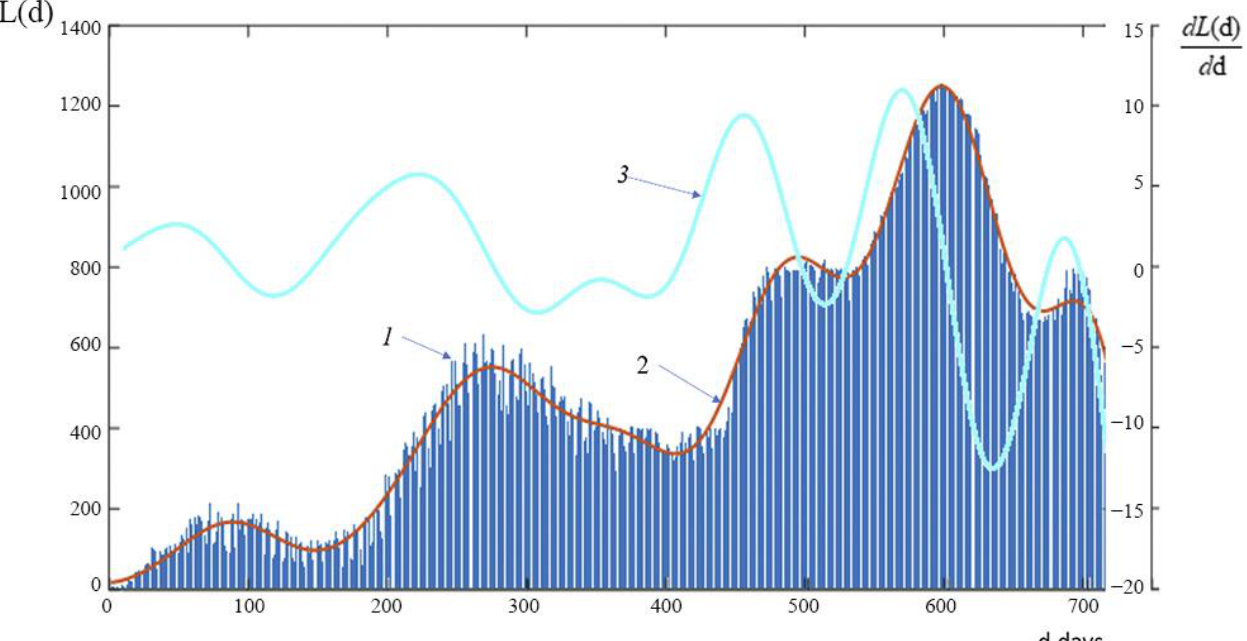
Figure 4. Time variance for the daily number of new lethal cases in Russia. 1—the real dates of new cases of death from COVID-19; 2—the average dates of new cases of death from COVID-19; 3—the velocity of the average dates of new cases of death from COVID-19.